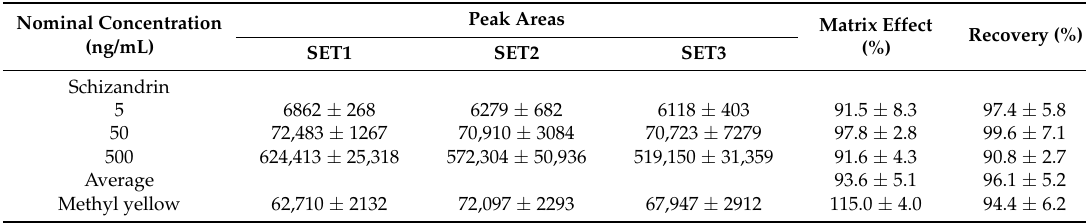
Table 2. Recovery and matrix effect of schizandrin in rat plasma. Nominal Concentration (ng/mL)